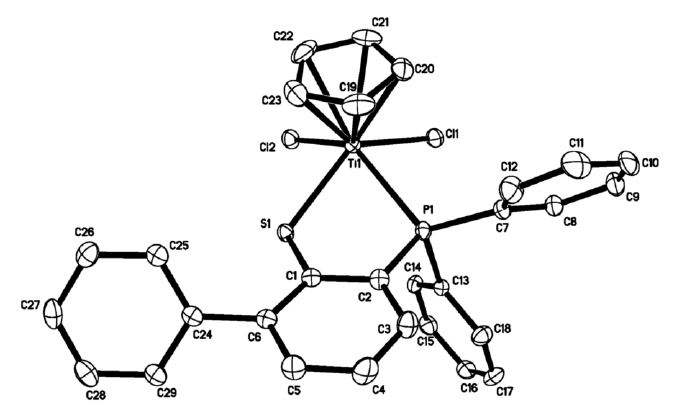
Figure 2. Molecular structure of complex 2b with thermal ellipsoids at 30% probability level. Hydrogen atoms are omitted for